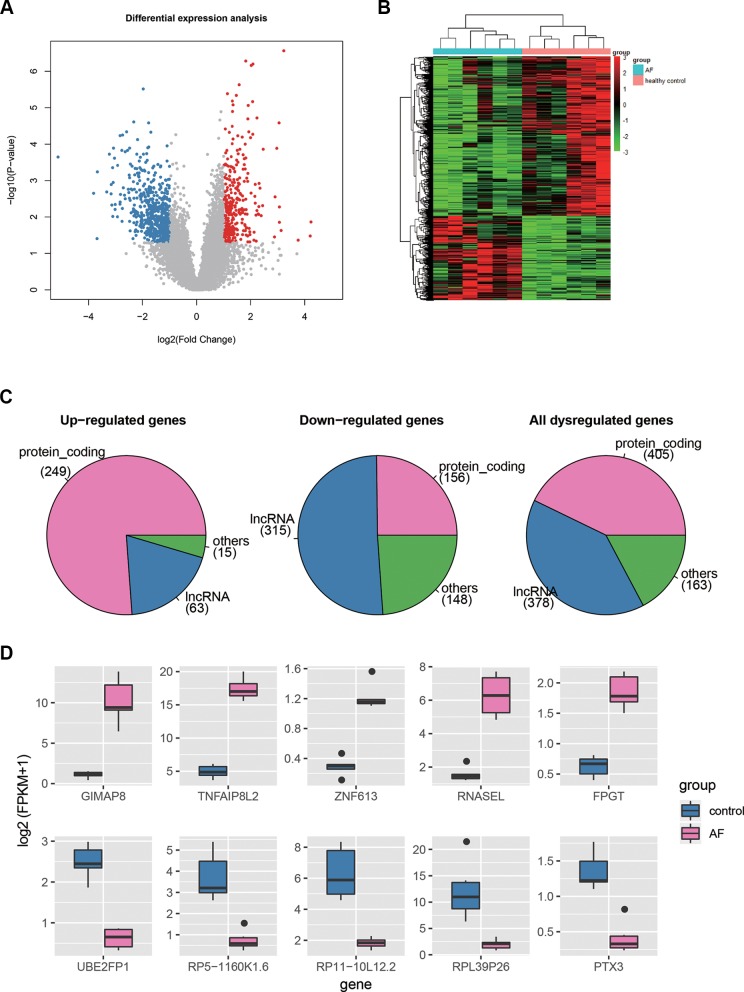
The differentially expressed genes in AF. (A) The volcano plot displays the up-regulated (red dots) and down-regulated (blue dots) genes. (B) The heat-map shows the scaled gene expression of dysregulated genes. (C) The number of PCGs, lncRNAs, and other ncRNAs in up-regulated, down-regulated, and all dysregulated genes. (D) The expression levels of the top-five up-regulated and down-regulated genes in AF and control.